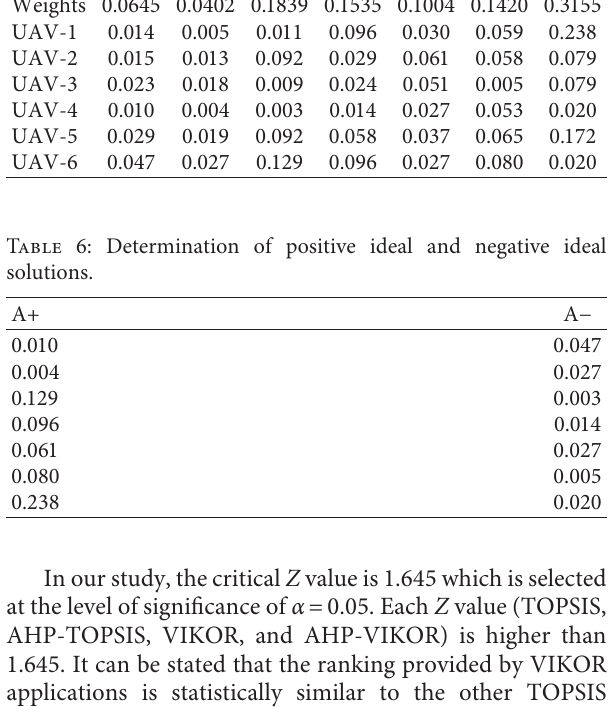
Figure 2: The decision hierarchy for the UAV selection process. Table 7: Final ranking for only TOPSIS and AHP-TOPSIS. Table 5: Weighted evaluation matrix for the UAVs. Alt.